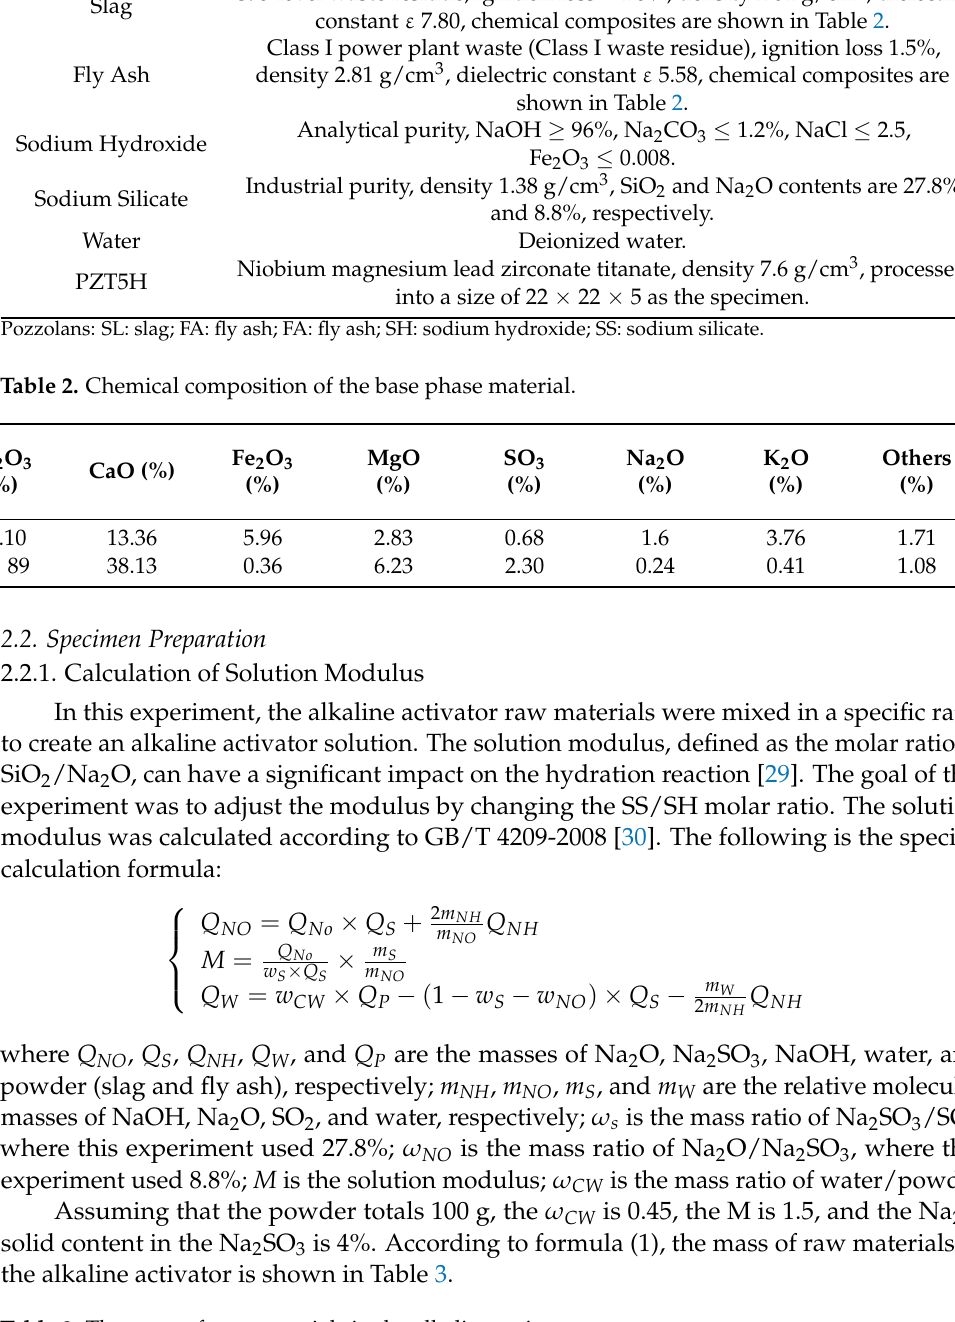
Table 3. The mass of raw materials in the alkaline